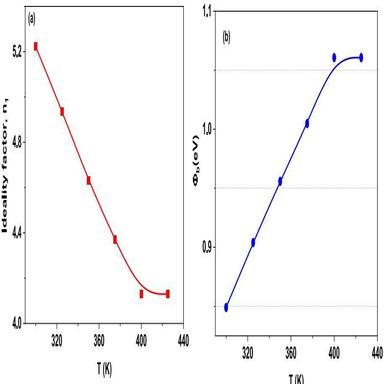
(a) Plot of ideality factor, n1 vs. T, and (b) Plot of barrier height, Φb vs. T of PVA/p-Si heterojunction.